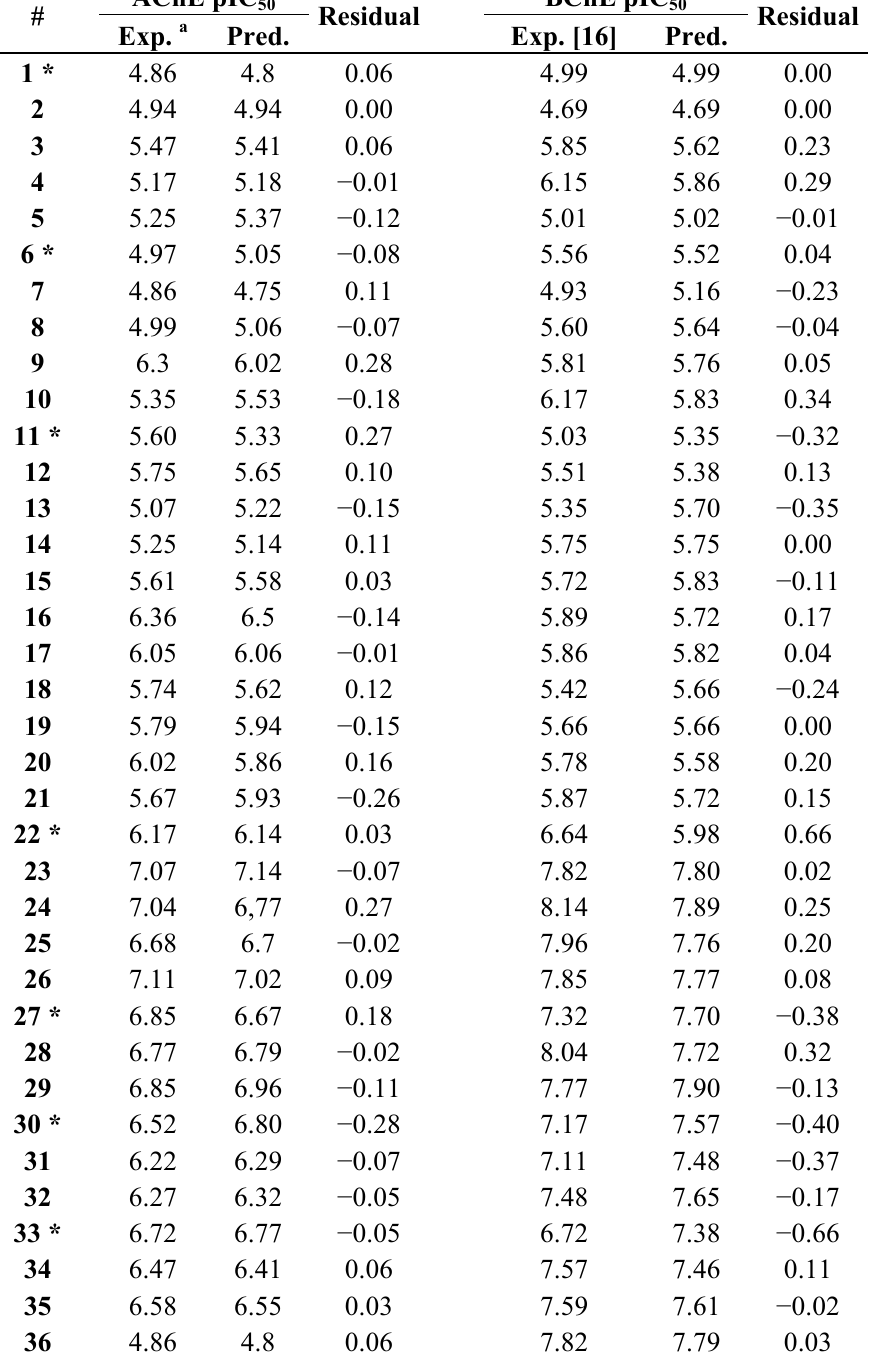
Table 4. Experimental and predicted pIC of AChE and BChE inhibitors using the best HQSAR